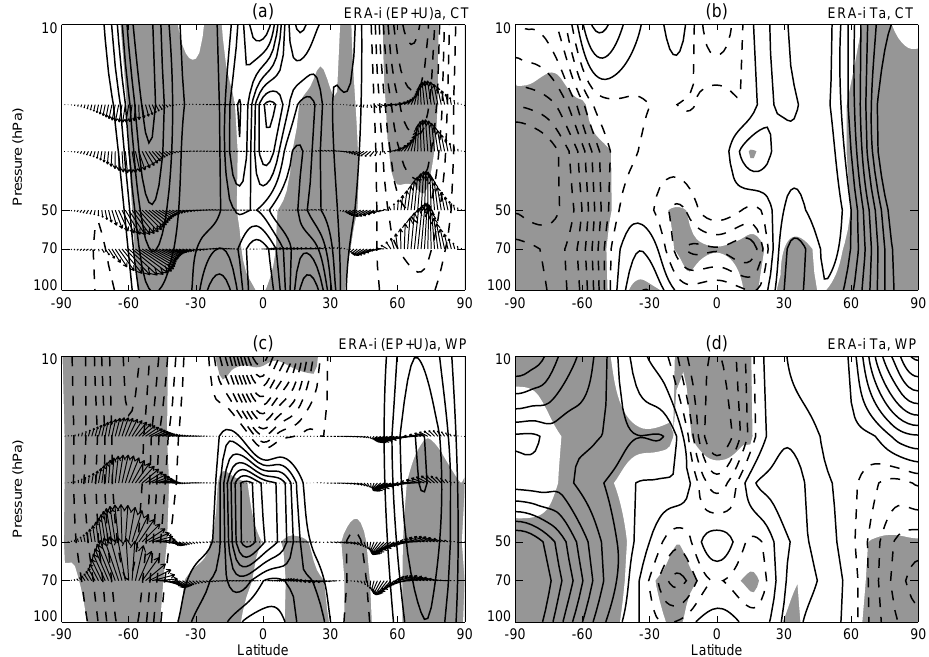
Fig. 8. Composite anomalies of the E-P flux and zonal wind for (a) canonical El Ni˜no events and (c) El Ni˜no Modoki events, based on ERA-Interim data for 1979–2010. The unit horizontal vector is 10 7 kgs − 1 and the unit vertical vector is 10 5 kgs − 1 . The contour interval for zonal wind anomalies is ± 0.25ms − 1 . Composite anomalies of temperature for (b) canonical El Ni˜no events and (d) El Ni˜no Modoki events, based on ERA-Interim data for 1979–2010. Contour interval for temperature anomalies, ± 0.15K. Anomalies that are significant at the 90% confidence level according to Student’s t-test are shaded. Solid and dashed lines represent positive and negative anomalies,